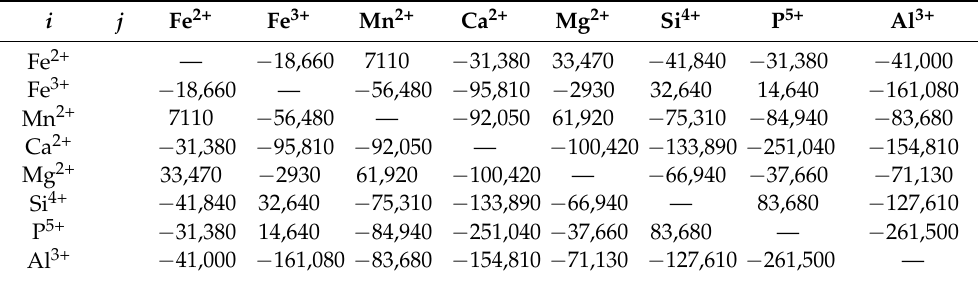
The conversion from α to α is shown in Equation (8), where the sub- PO 2.5 ( R . S . ) P 2 O 5 ( L ) script indicates the reference state of the activity. (R.S.) indicates the pure PO 2 . 5